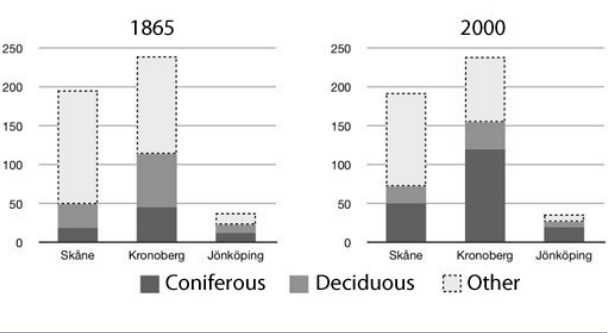
Fig. 3. Land cover in River Helge å catchment within a buffer of 1000 m extending from the Helge å River main flow. A comparison between a composite of maps from 1865 to 1869 (Topographical Corp of the Swedish Armed Forces) and data from 2000 based on classified satellite images (Kontinuerlig Naturtypskartering av Skyddad Natur [KNAS] project, Swedish EPA, unpublished data ). Data show an increase of total forest cover and an increase in coniferous forest cover